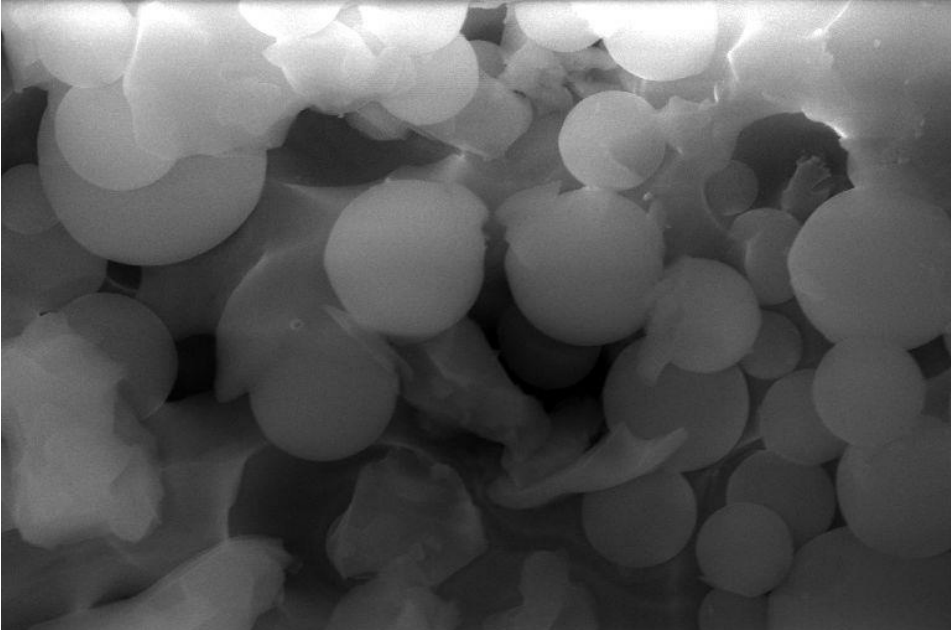
Figure 11. SEM images of adsorbent 2 after adsorption.